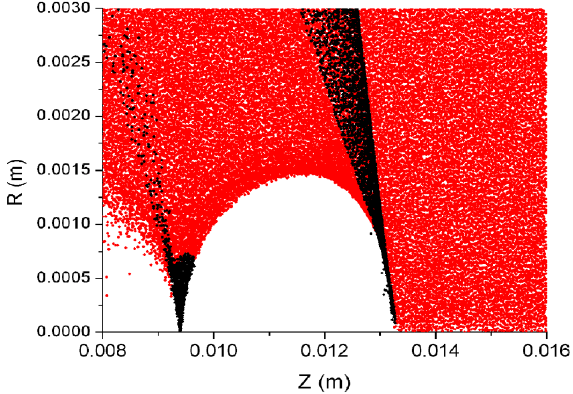
FIG. 2. (Color) Configuration space from MAGIC cylindrically symmetric PIC simulation with ~ QQ (cid:5) 20 , k 0 : 2 , and beam center at z (cid:4) 1 : 33 cm . Color code indicates electron positions that have relativistic positive momenta =m c > 1 in black, with all other plasma electrons colored p z e red. The initially accelerated plasma electrons are just ahead of the blowout region, where radial motion moves the electrons away from the beam